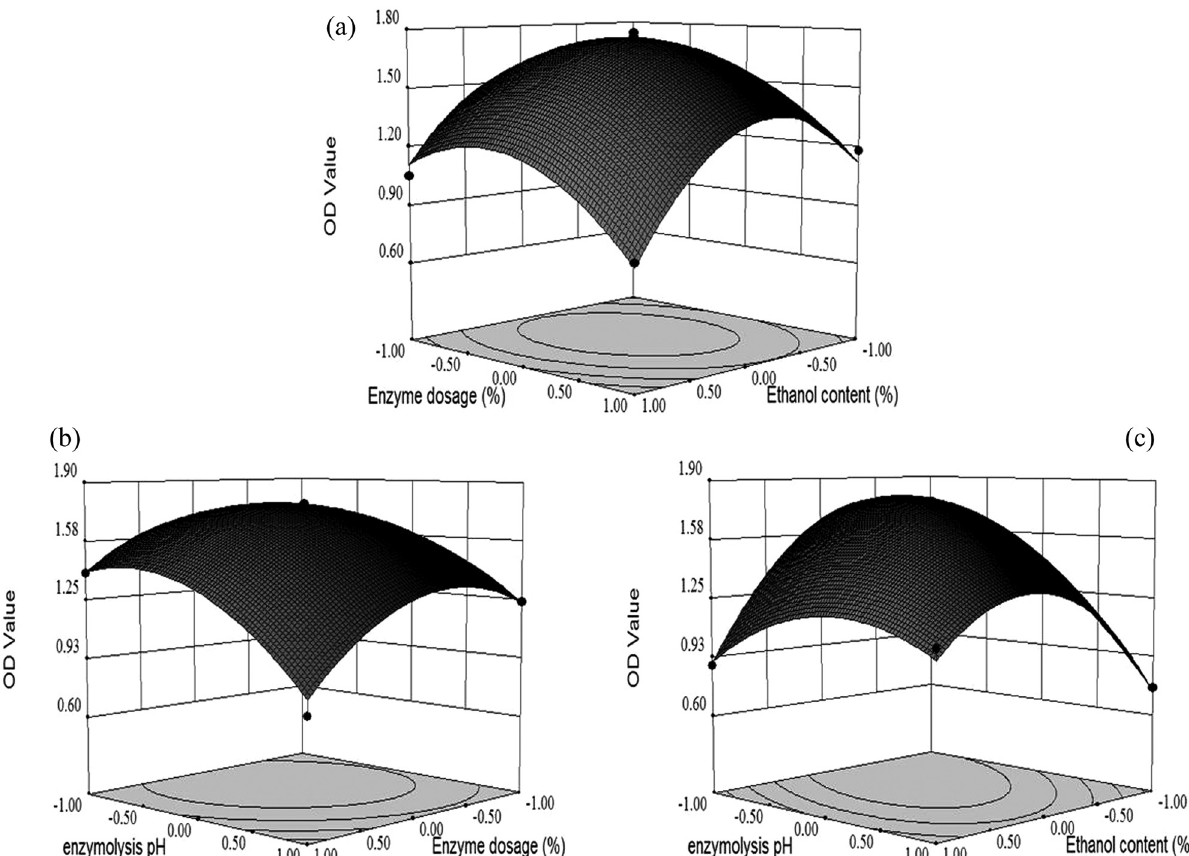
Figure 3: The contour map and response surface graph between various factors. Combinative e ff ects of enzyme dosage × ethanol con - centration ( a ) , enzymolysis pH × enzyme dosage ( b ) , and enzymolysis pH × ethanol concentration ( c ) on pigment extraction from jujube fruits were monitored ( n = 3; error bar, a standard deviation of the sample, SD; OD value is the optical density value measured at 280 nm )